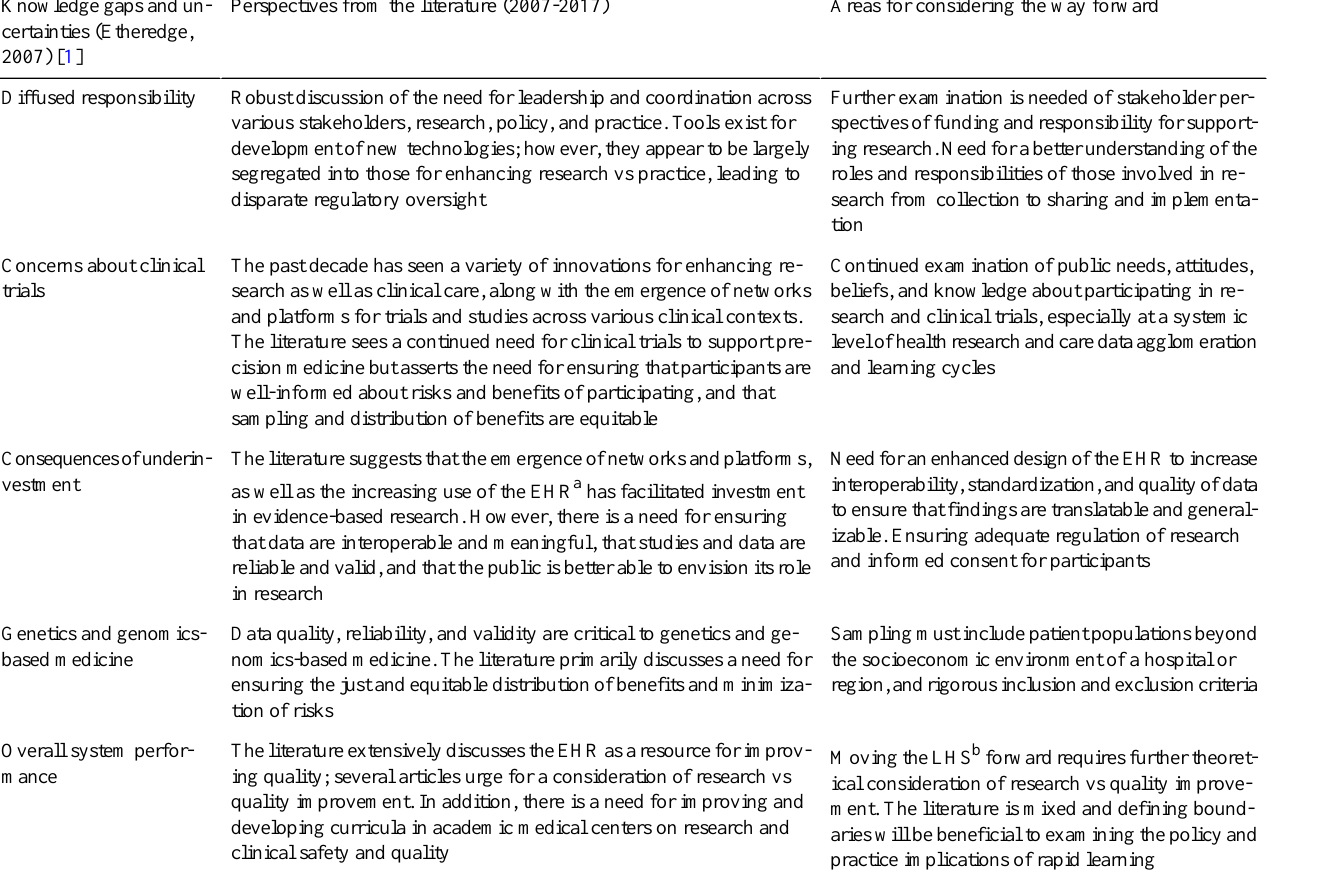
Table 3. Progress over the past decade in addressing knowledge gaps and